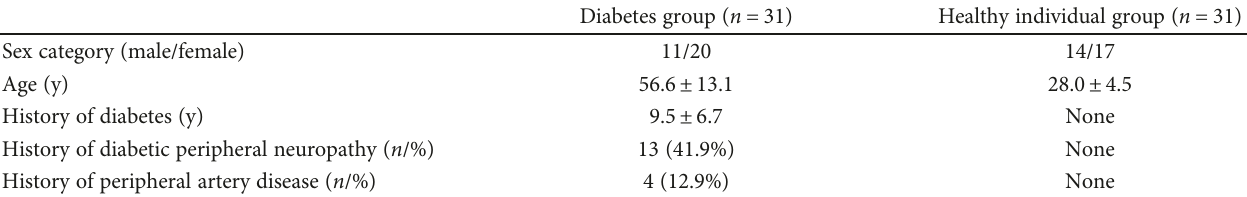
Table 2: Baseline data of diabetic patients and healthy individuals.